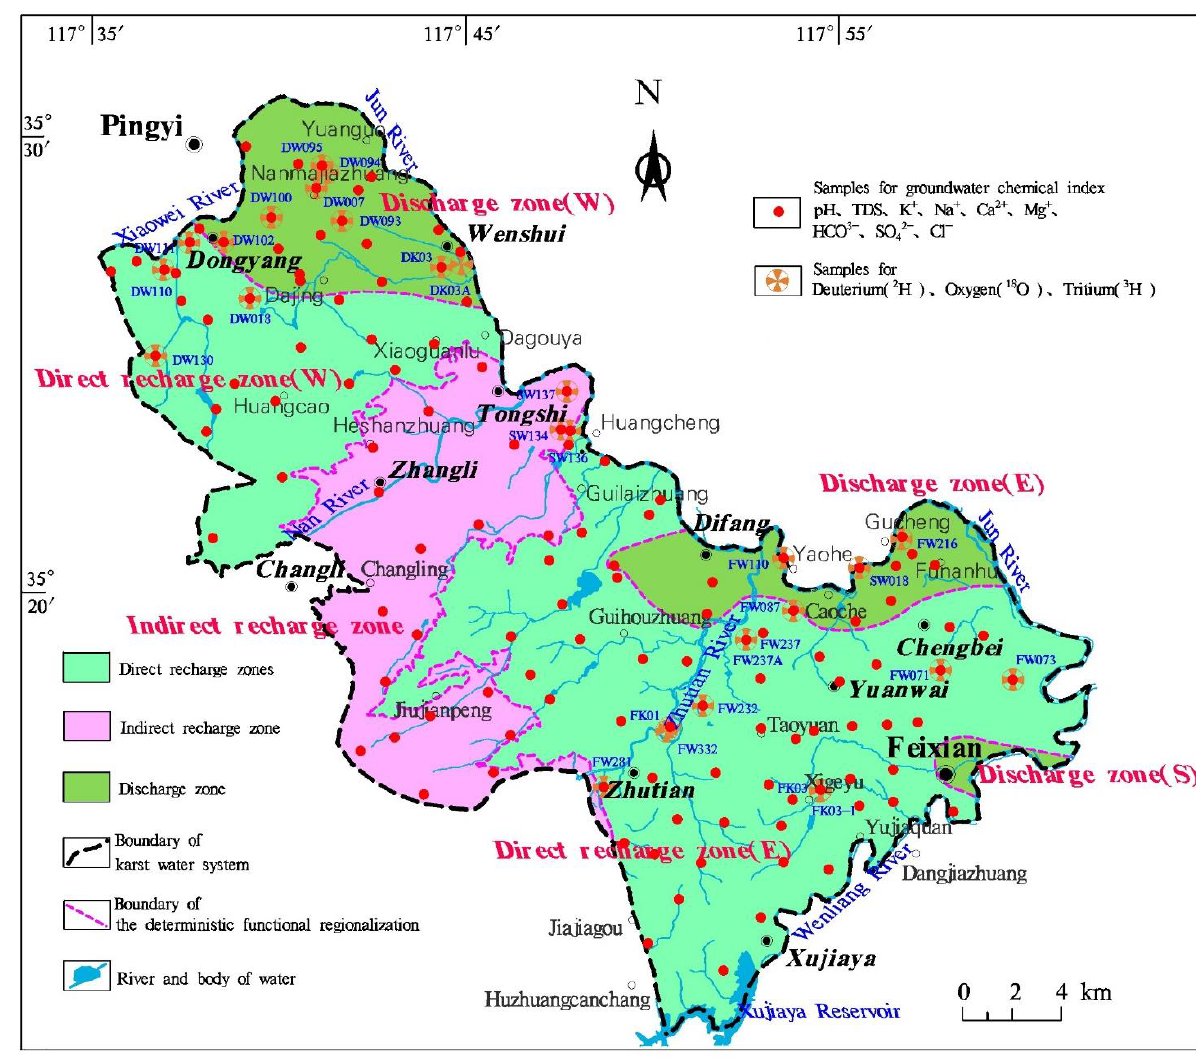
Figure 4. Karst water sampling sites in the study region. Table 1. Typical hydrochemical and isotopic samples of precipitation and karst water. Sample No. Sample